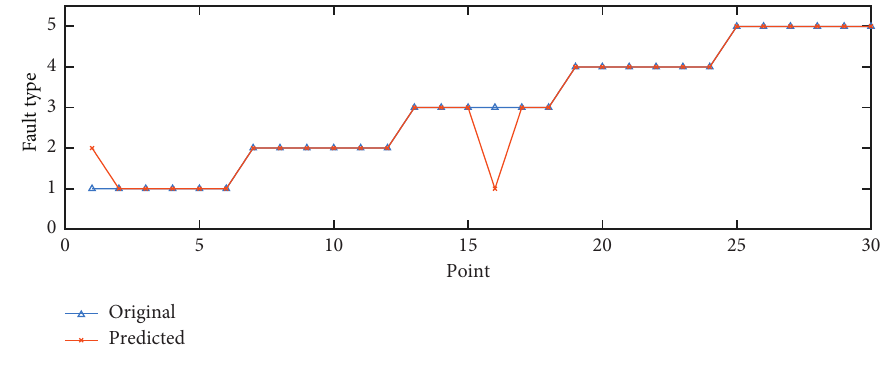
Figure 6: Result of fault identification. Table 3: Various methods of fault identification results.